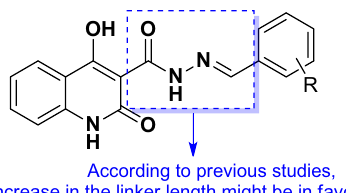
Figure 2. SARs studies of the current study and previously reported